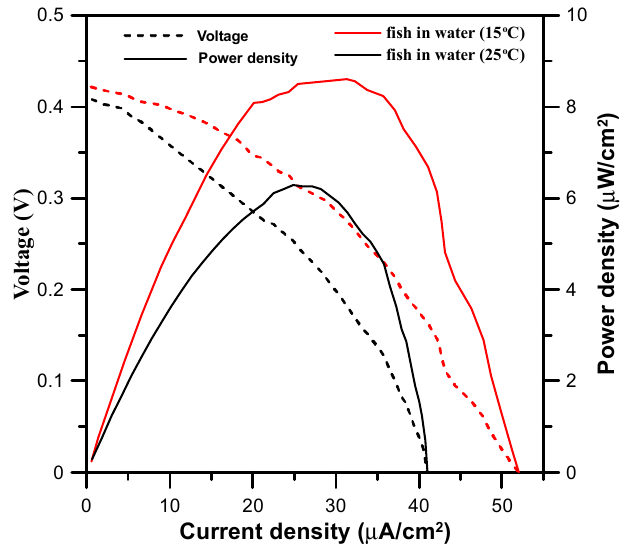
Figure 5. Polarization curves, and current and power densities of the N-EFC inserted in the free- free-swimming fish and operated underwater at T w = 15 ◦ C and 25 ◦ swimming fish and operated underwater at T w = 15 °C and 25 °C.